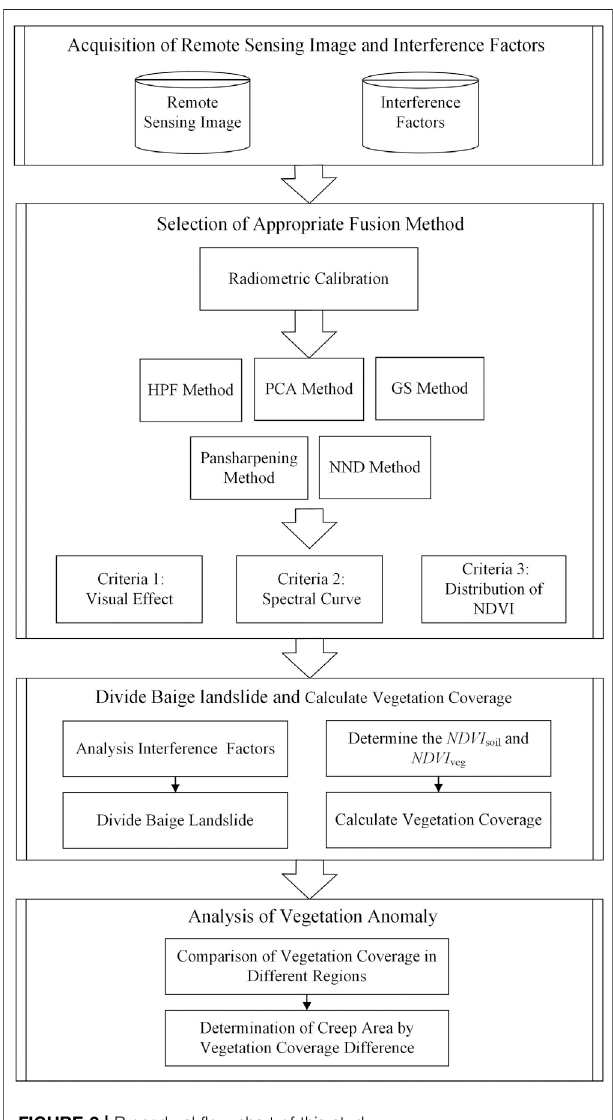
FIGURE 2 | Procedural fl ow chart of this